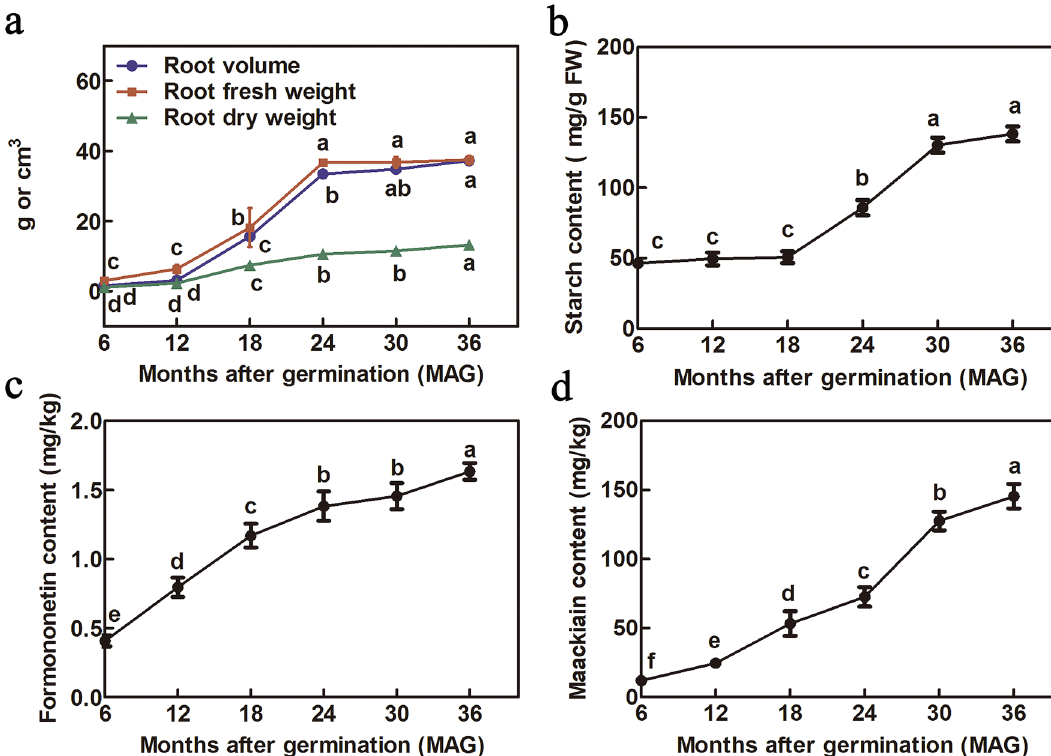
Figure 1. Determination of growth indices of C. speciosa roots at different developmental ages. ( a ) Root volume, fresh weight and dry weight. ( b ) Starch content. ( c ) Formononetin content. ( d ) Maackiain content. All data shown reflect the average mean of three biological replicates ( n = 3). Lowercase letters represent the significance test results at 0.05